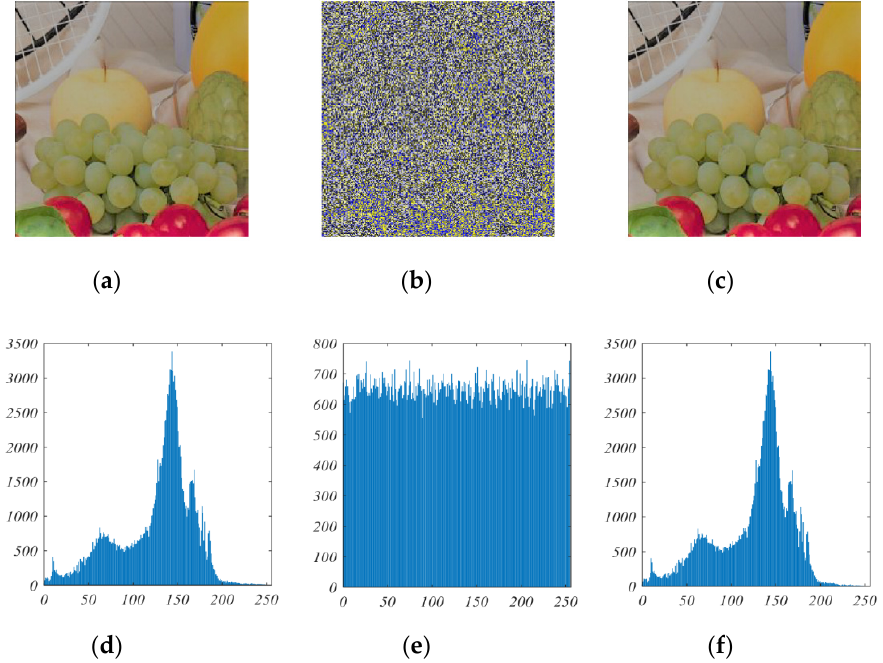
Figure 23. Test of “fruits.jpg”, 236 × 235: ( a ) plain image, ( b ) encrypted image, ( c ) recovered image, ( d – f ) histograms consistent with ( a – c ), respectively.